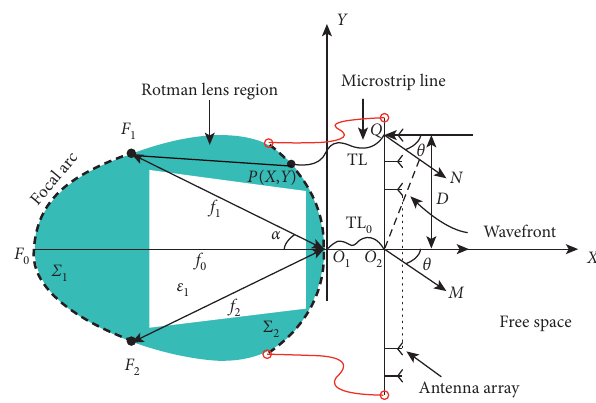
Figure 30: Microstrip Rotman lens parameters.